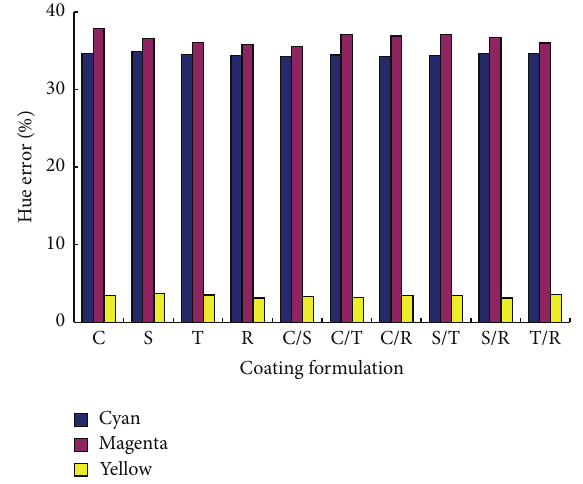
Figure 11: Effects of coating formulations on cyan, magenta, and yellow (CMY) hue errors of color inkjet-printed papers. C: CaCO 3 ; S: SiO 2 ; T: talc; R: sericite, with mixing ratios of 50/50.